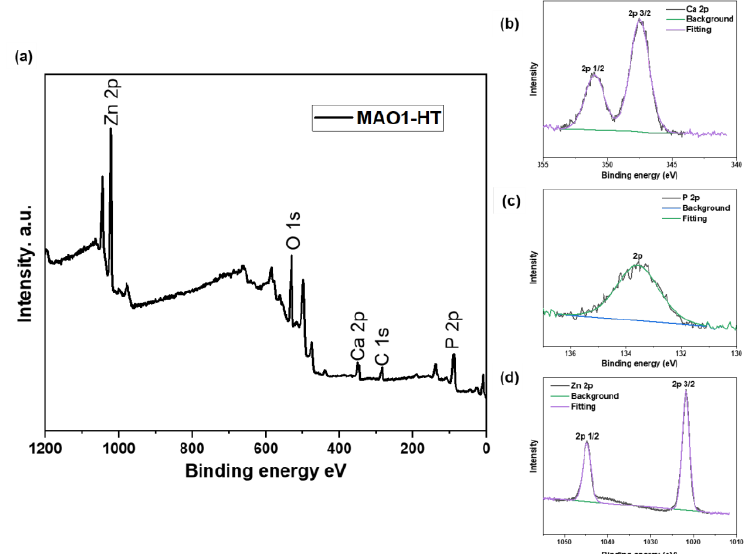
Figure 3. ( a ) XPS analysis detected on the surface of MAO1 − HT. High-resolution spectra of ( b ) Ca 2p, ( c ) P 2p, and ( d ) Zn 2p.